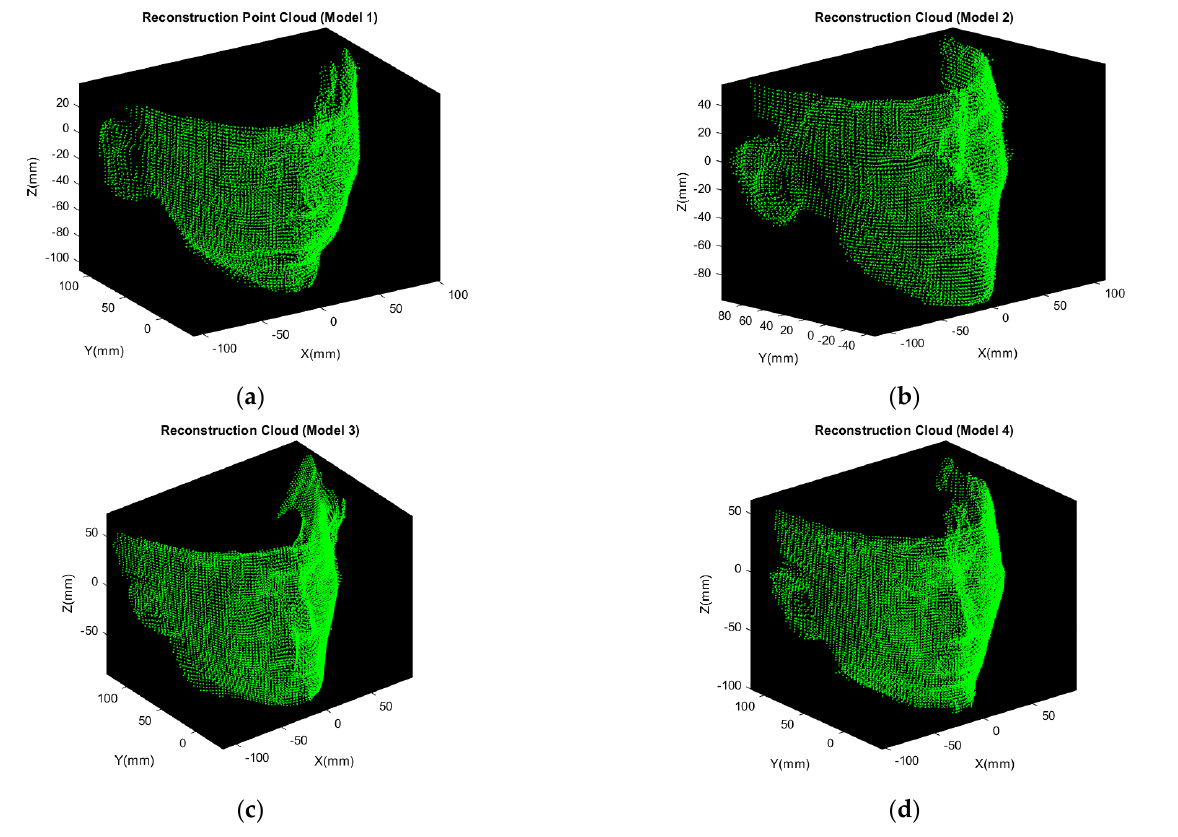
Figure 17. 3D face reconstruction of four laboratory members: ( a ) Model 1; ( b ) Model 2; ( c ) Model 3; ( d ) Model 4.